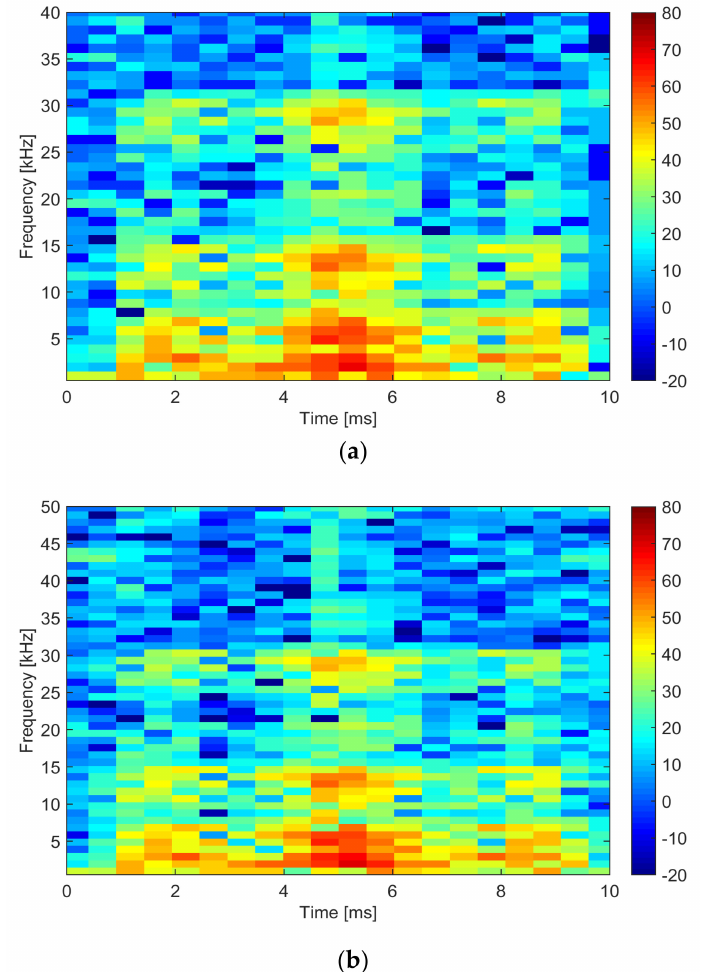
Figure 6. ( a ) Zoom on the frequency axis of Figure 5b for the frequency resolution of 976 Hz, where the change of the instantaneous frequency between 4 and 6 ms is well visible; and ( b ) additional spectrum obtained by replacing symlet1 with bior1.3